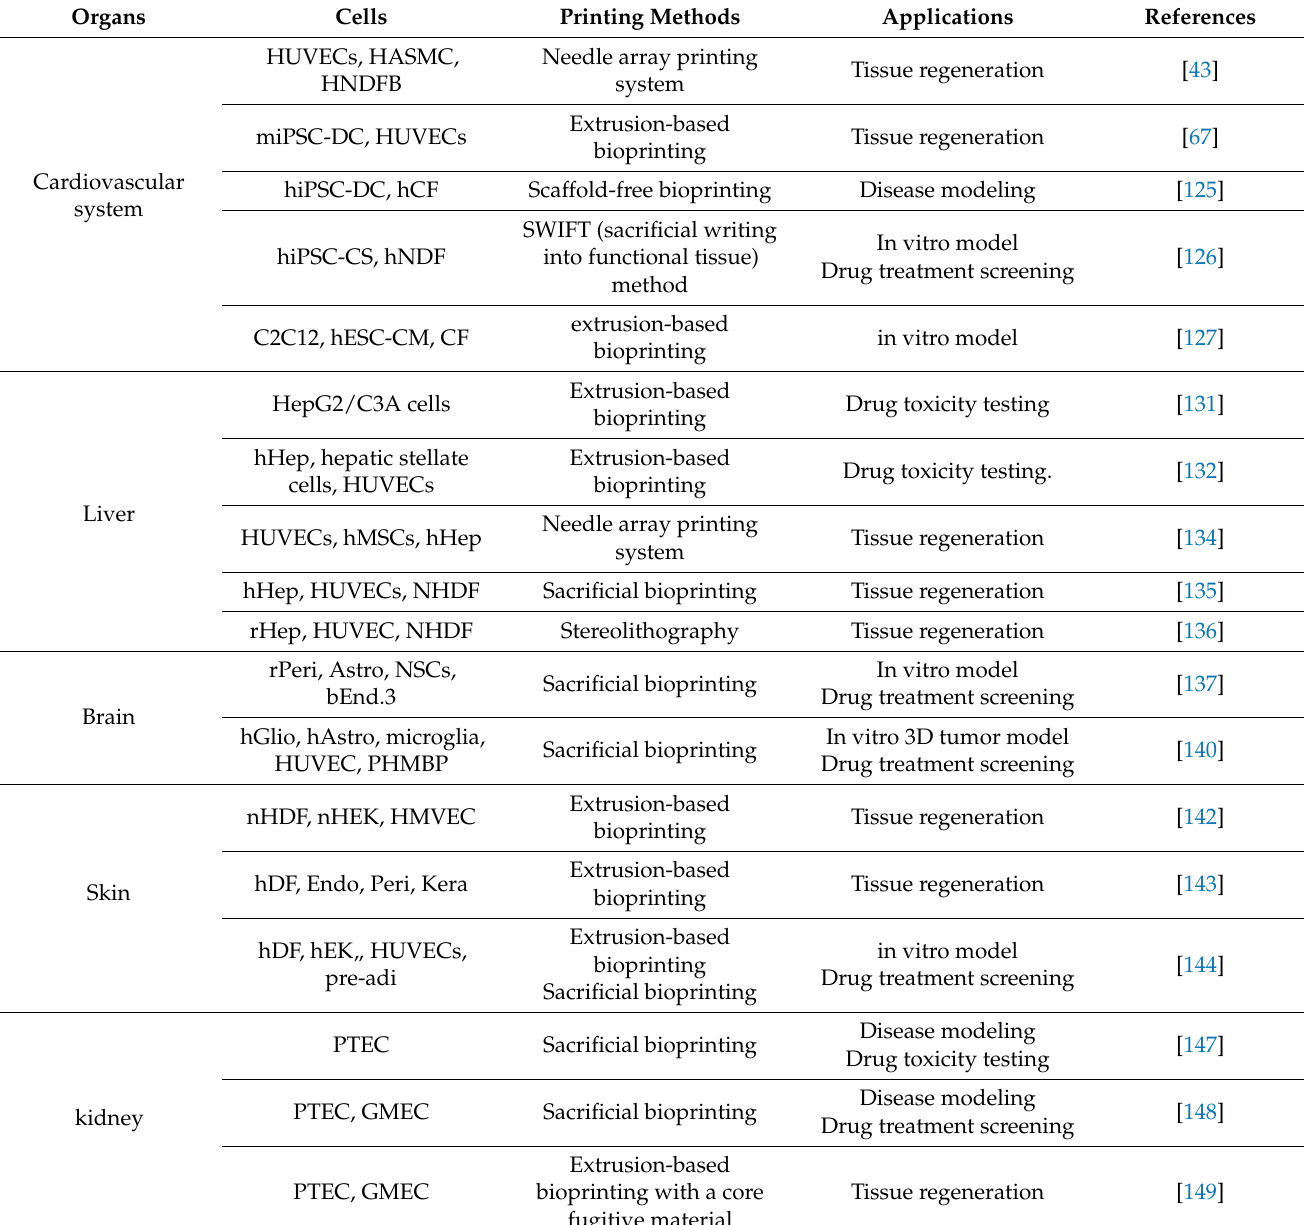
Table 4. Applications of the 3D Bioprinting vascularized